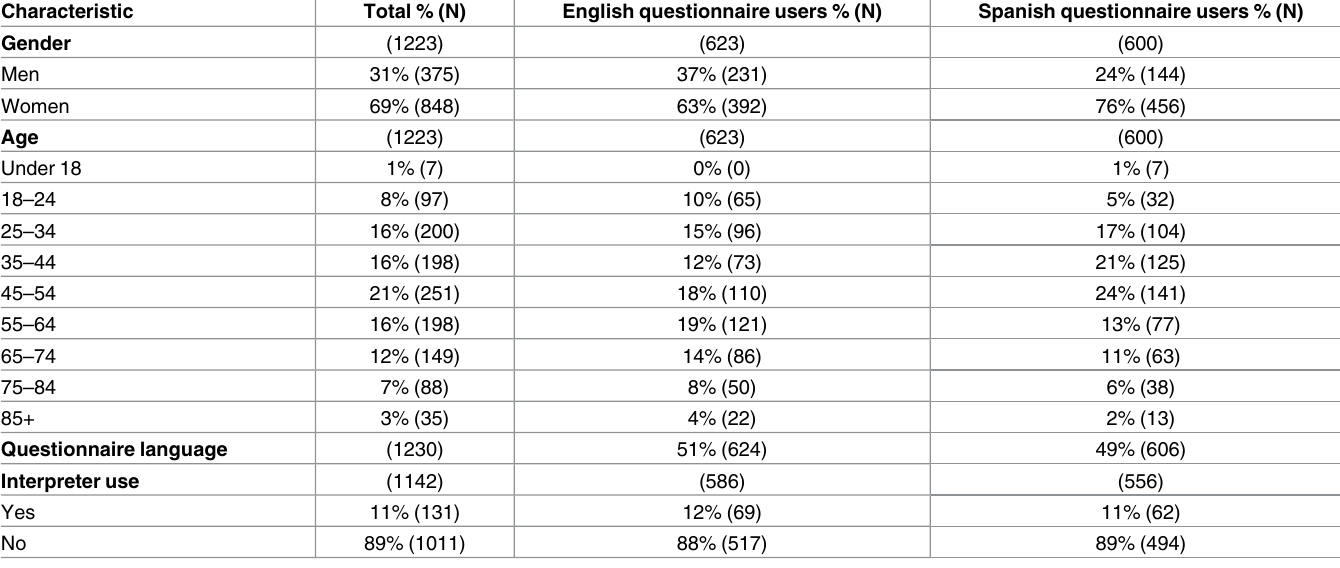
Table 4. Pilot data collection: respondent